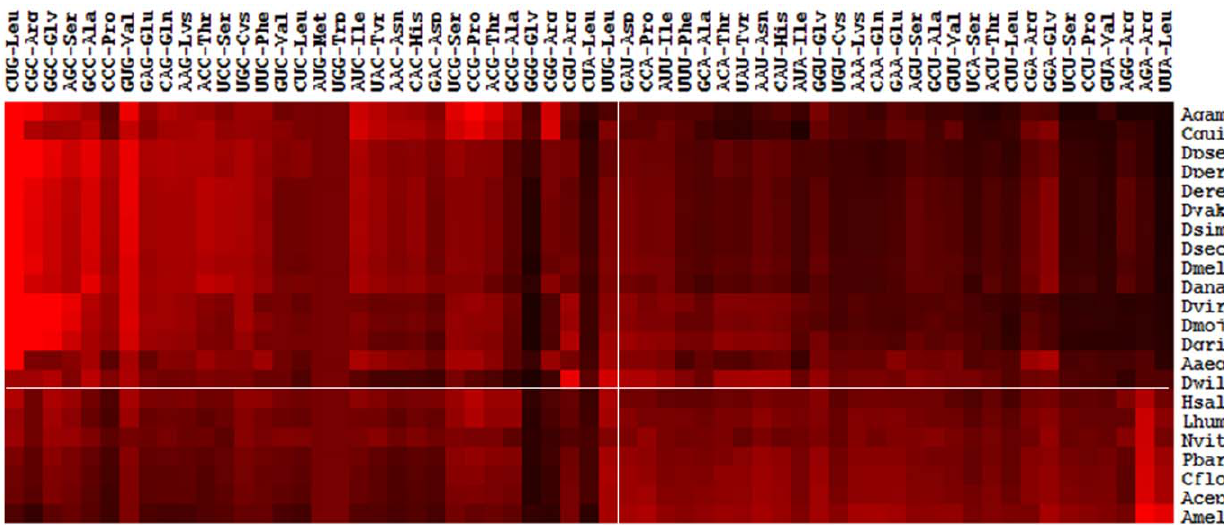
Figure 1. Hierarchal clustering of RSCU values of each codon among the 22 insect species. Each square on the self-organizing map represents the RSCU value of a codon (shown in columns) corresponding to the species (shown in rows). The color coding varies from black to red with low to high values of the RSCU respectively. The top-left quadrant shows the cluster of C or G ending codons that are frequently used in dipteran species relative to the hymenopteran species. The bottom-right quadrant represents the cluster of A or U ending codons that are frequently used in hymenopteran species relative to the dipteran species.